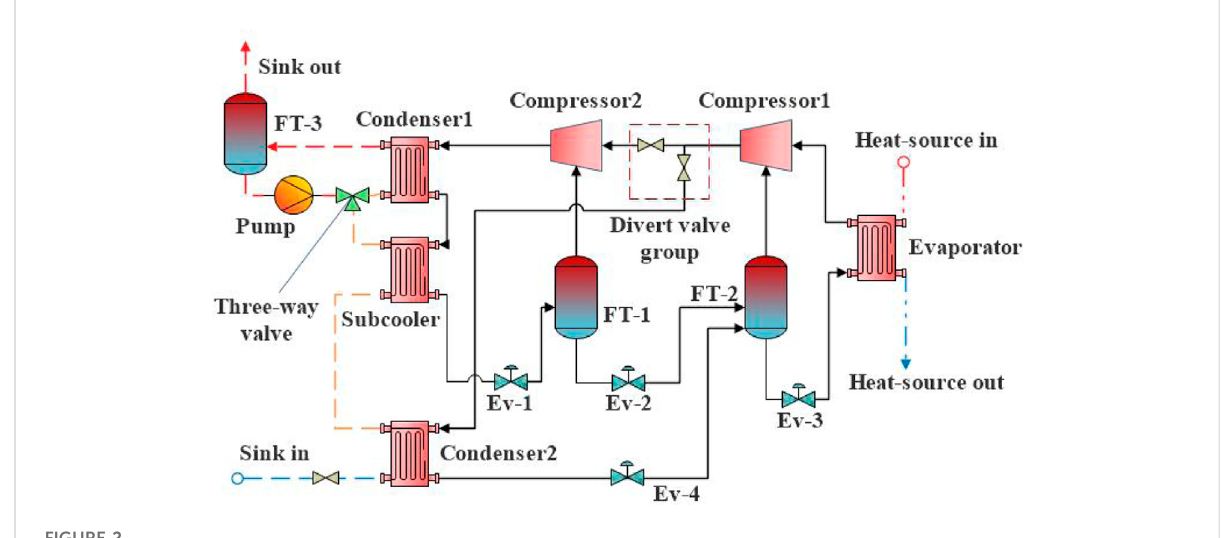
FIGURE 2 The structure of the dual- fl ash compound circulation